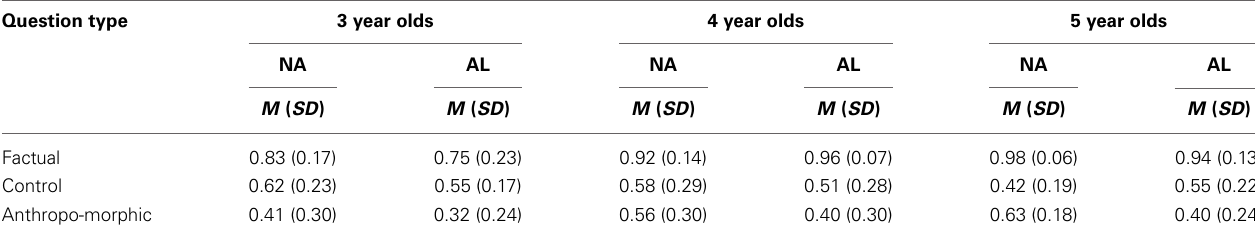
Table 1 | Mean proportion of correct responses for children in the No Anthropomorphism (NA) and Anthropomorphic Language (AL) conditions, Study